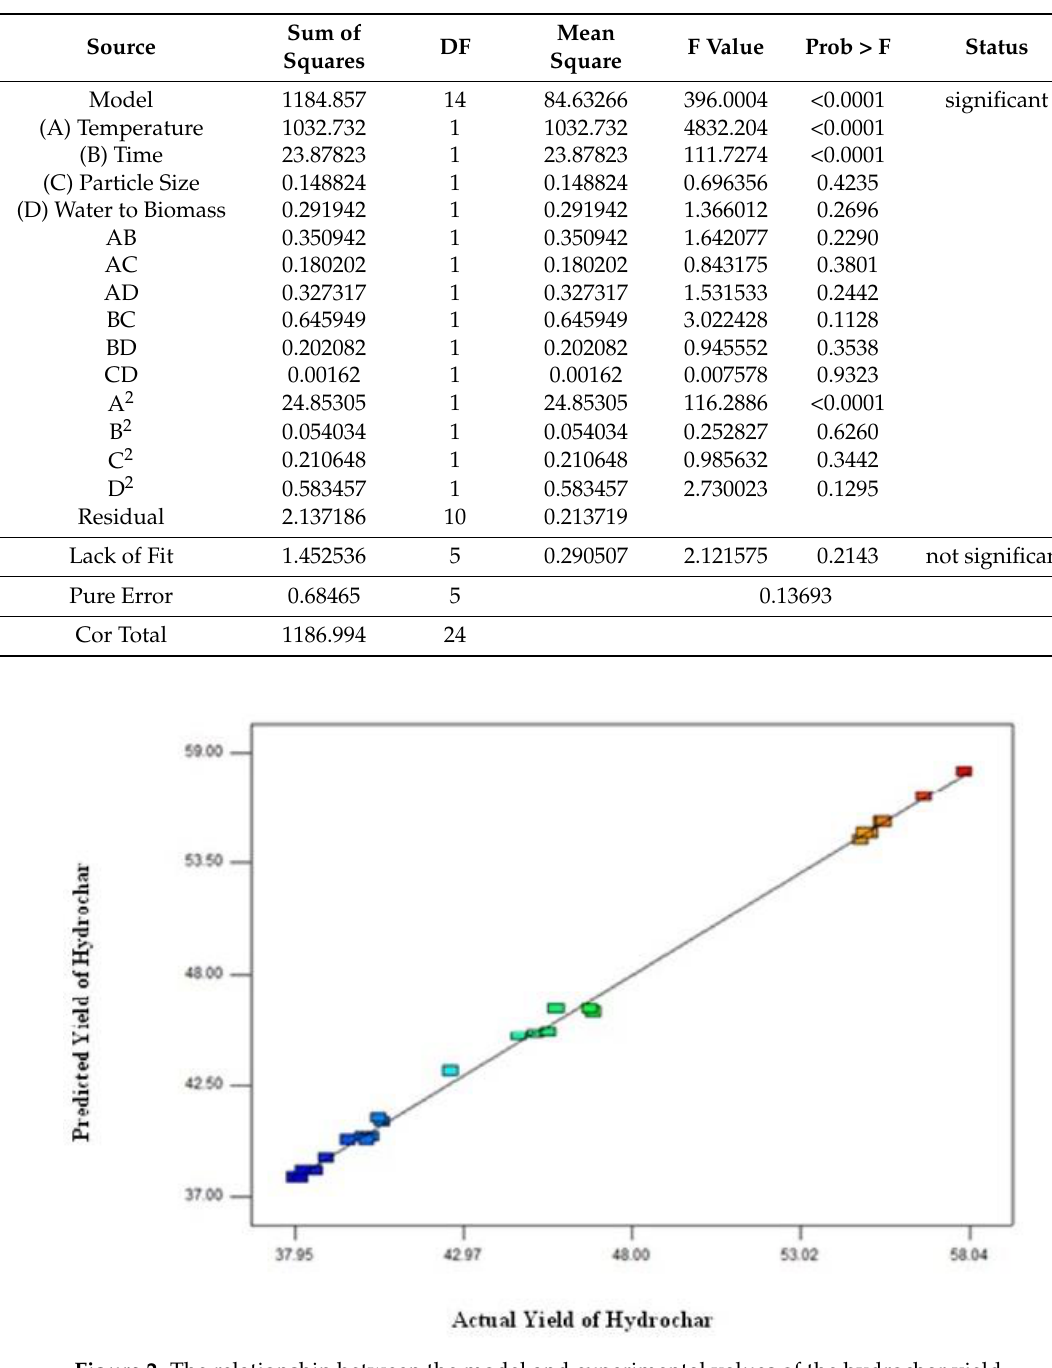
Figure 2. The relationship between the model and experimental values of the hydrochar yield.